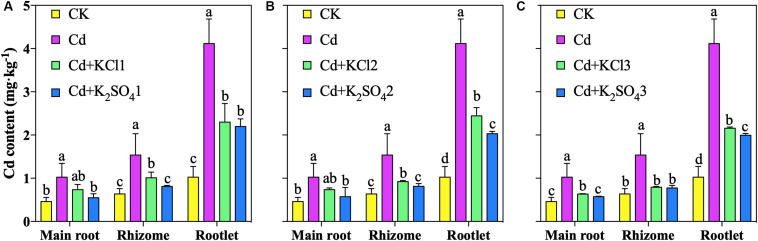
Effect of different types of K on Cd content in P. notoginseng (A denoted low application amount, KCl1: 0.171, K2SO41: 0.2 g⋅kg–1; B denoted medium application amount, KCl2: 0.513, K2SO42: 0.6 g⋅kg–1; C denoted high application amount, KCl3: 1.026, K2SO43: 1.2 g⋅kg–1). Different lowercase letters indicate the means are significantly different at P < 0.05.